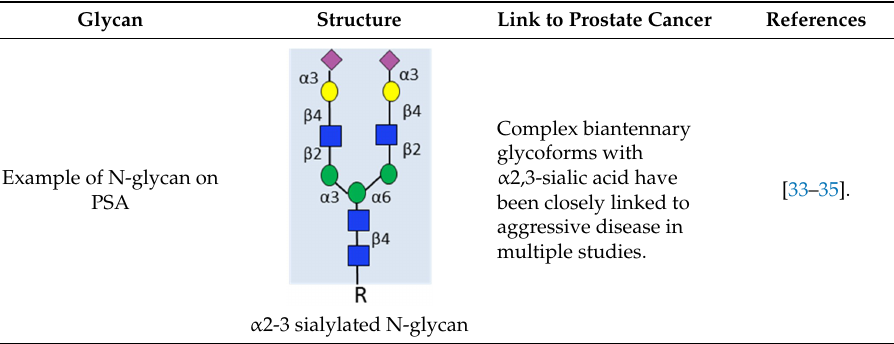
Table 1. Summary of glycan alterations in prostate cancer. PSA: prostate-specific antigen.